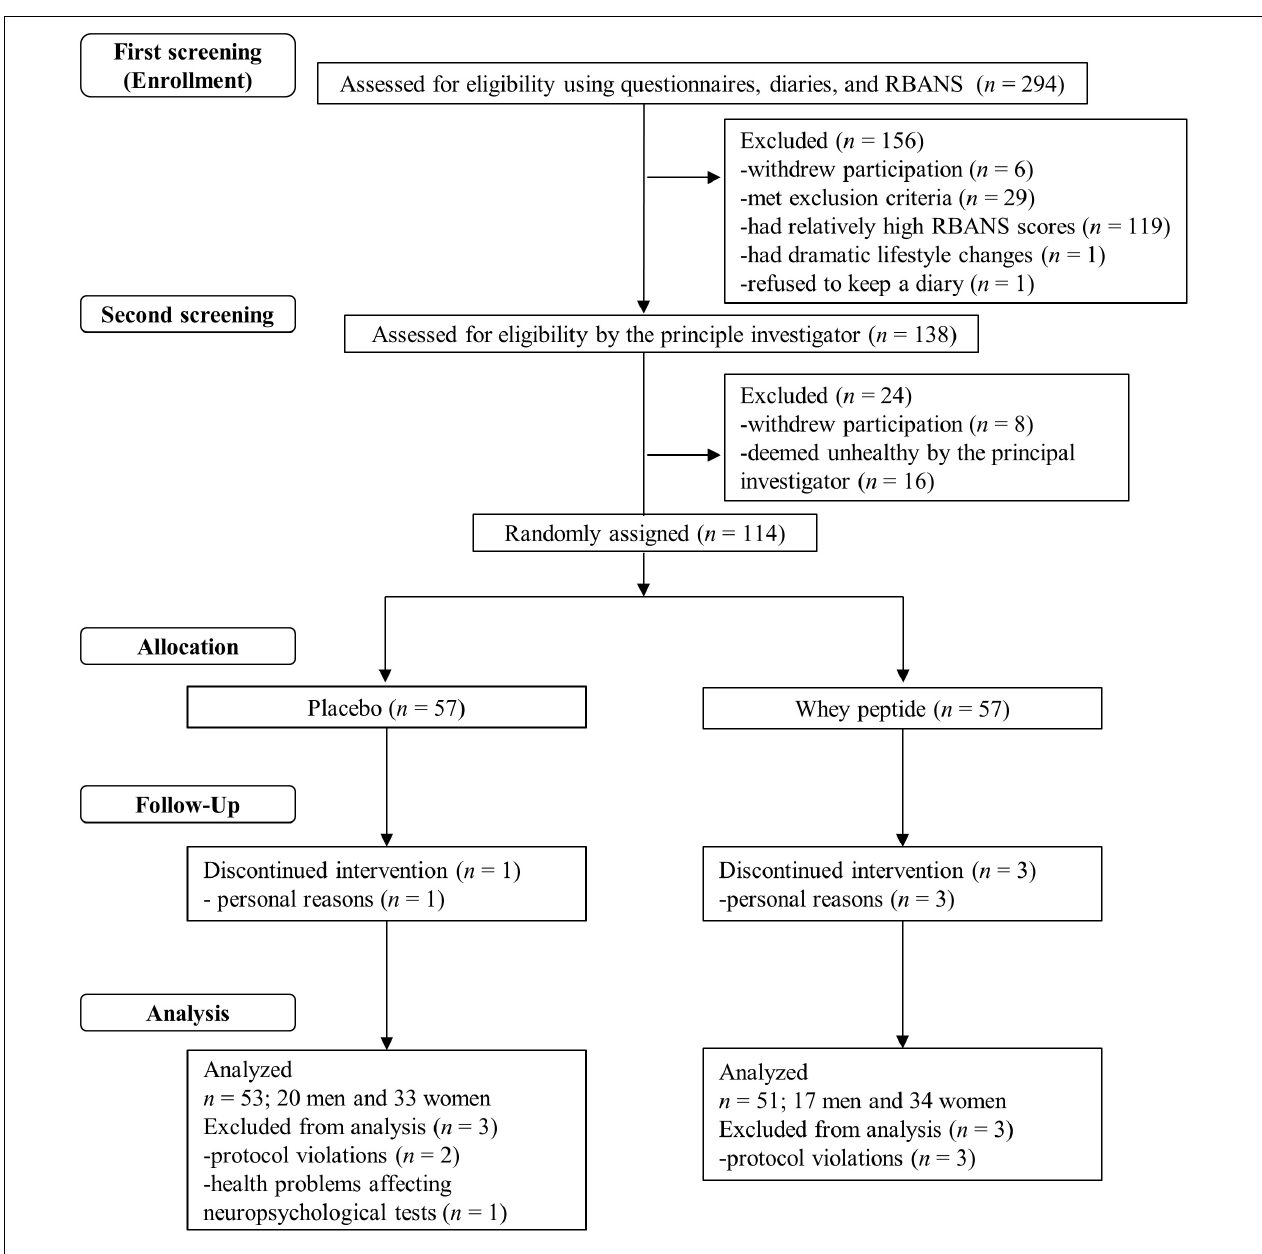
FIGURE 1 | Flow chart of the subject selection process. Out of 294 subjects who were screened, 114 subjects were included in the study. These subjects were randomly allocated to whey peptide ( n = 57) and placebo ( n = 57) groups. Three subjects in the whey peptide group and one subject in the placebo group dropped out of the study during the intervention. Three subjects in the whey peptide group and three in the placebo group were excluded from analysis, leaving 51 and 53 subjects in whey peptide and placebo groups, respectively, for